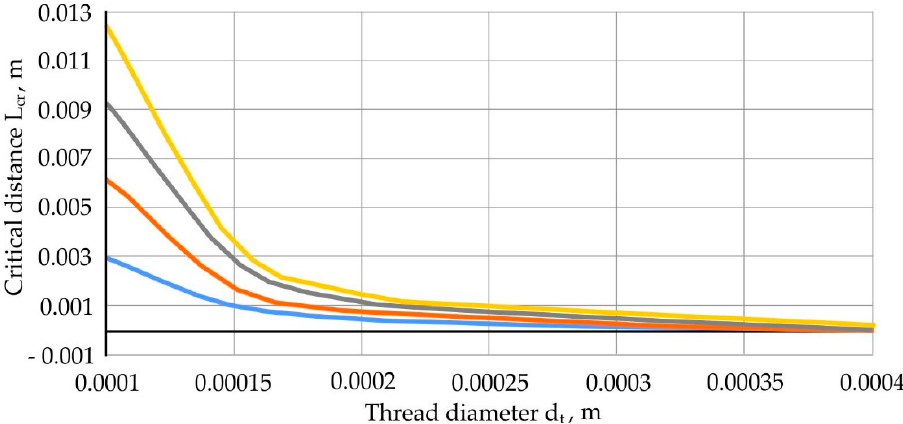
Figure 10. Dependence graphs of critical thread length L cr from the diameter of the thread d t at f fr = 0.12 and P = 0.26 × 10 − 6 .